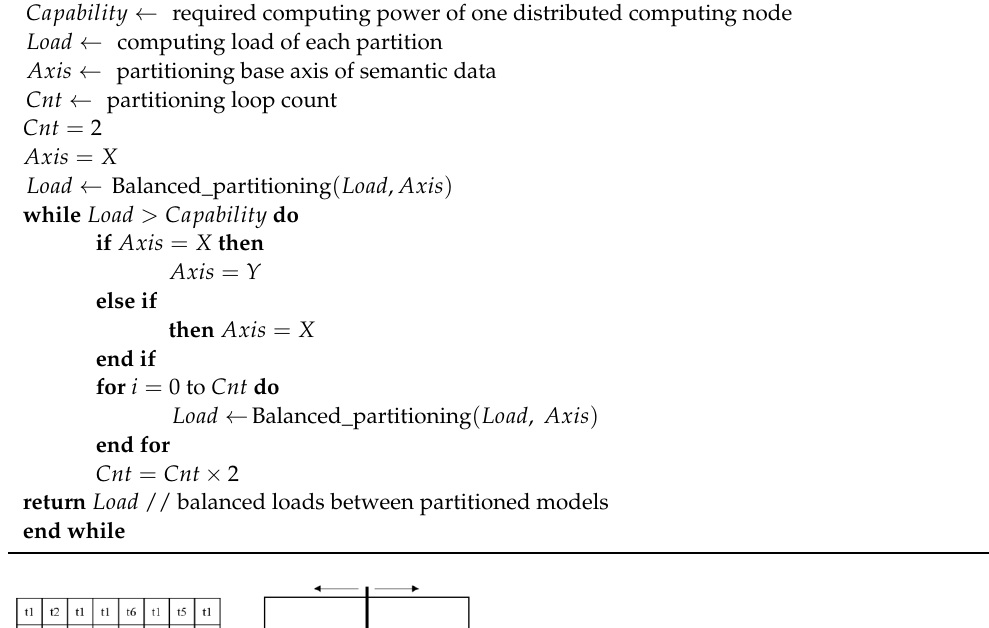
Algorithm 2 Balanced partitioning based on k-d tree algorithm